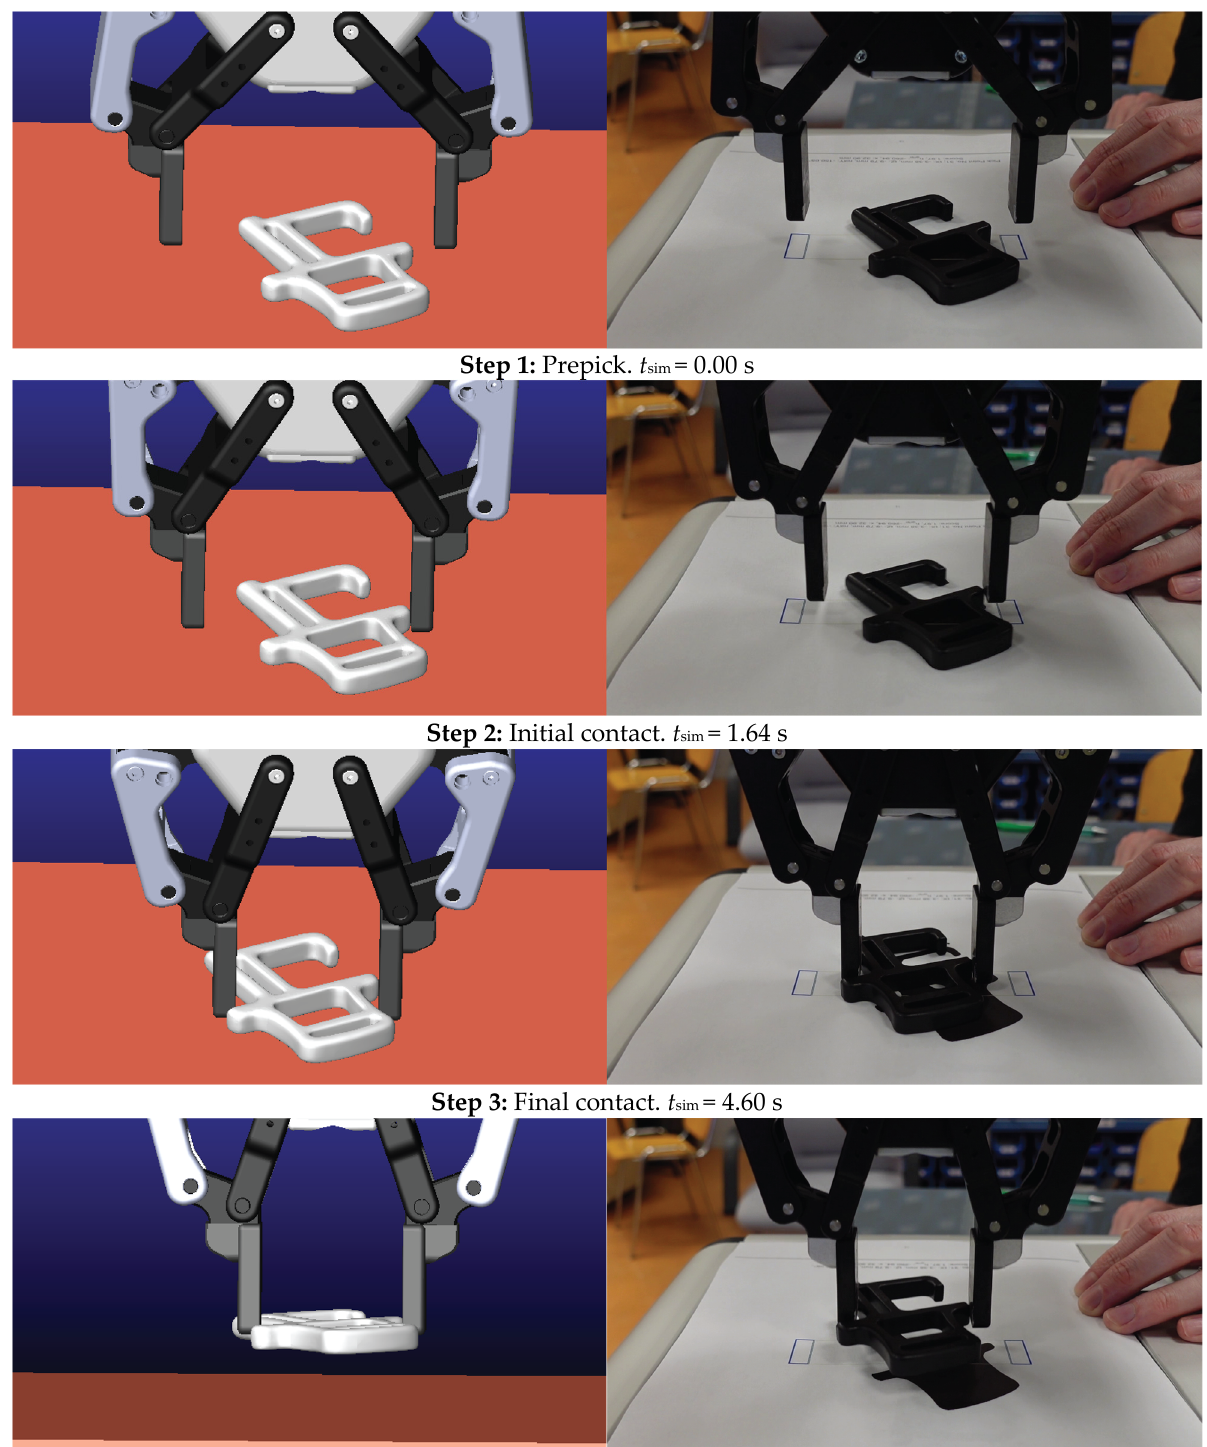
Figure 16. Graphical analysis of the second pick-point. Source: own.